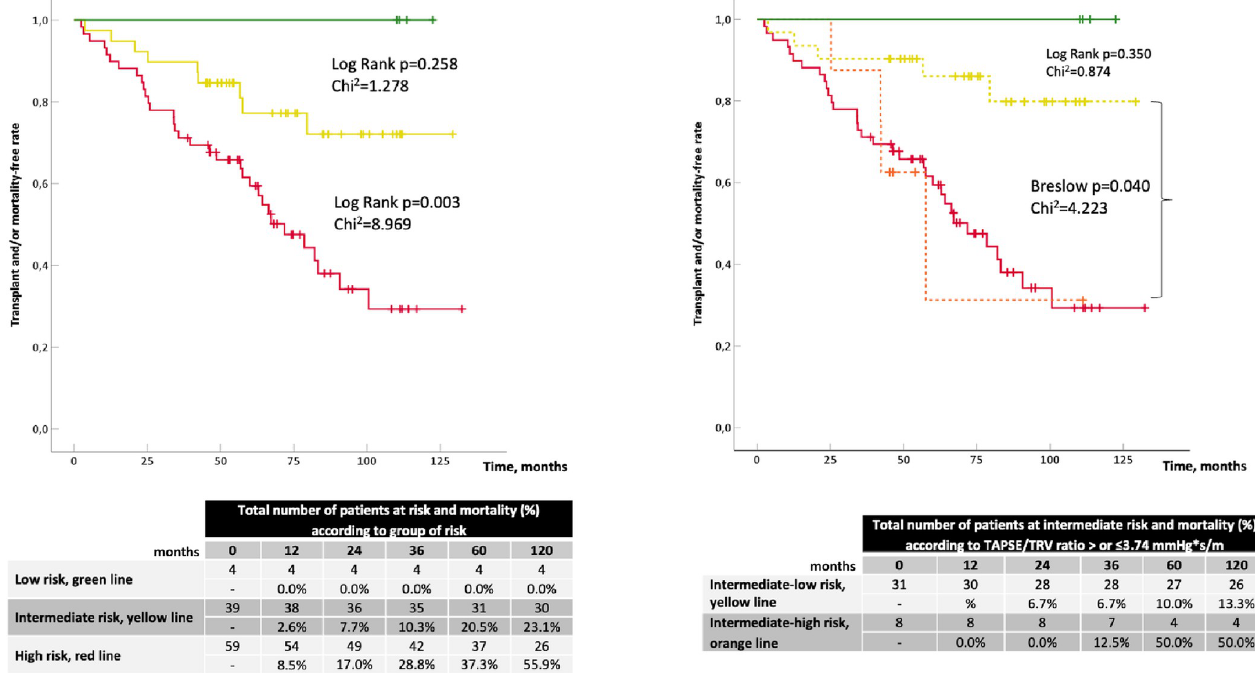
Fig 1. Kaplan-Meier curves according to PAH risk groups applying the strategy of COMPERA registry.